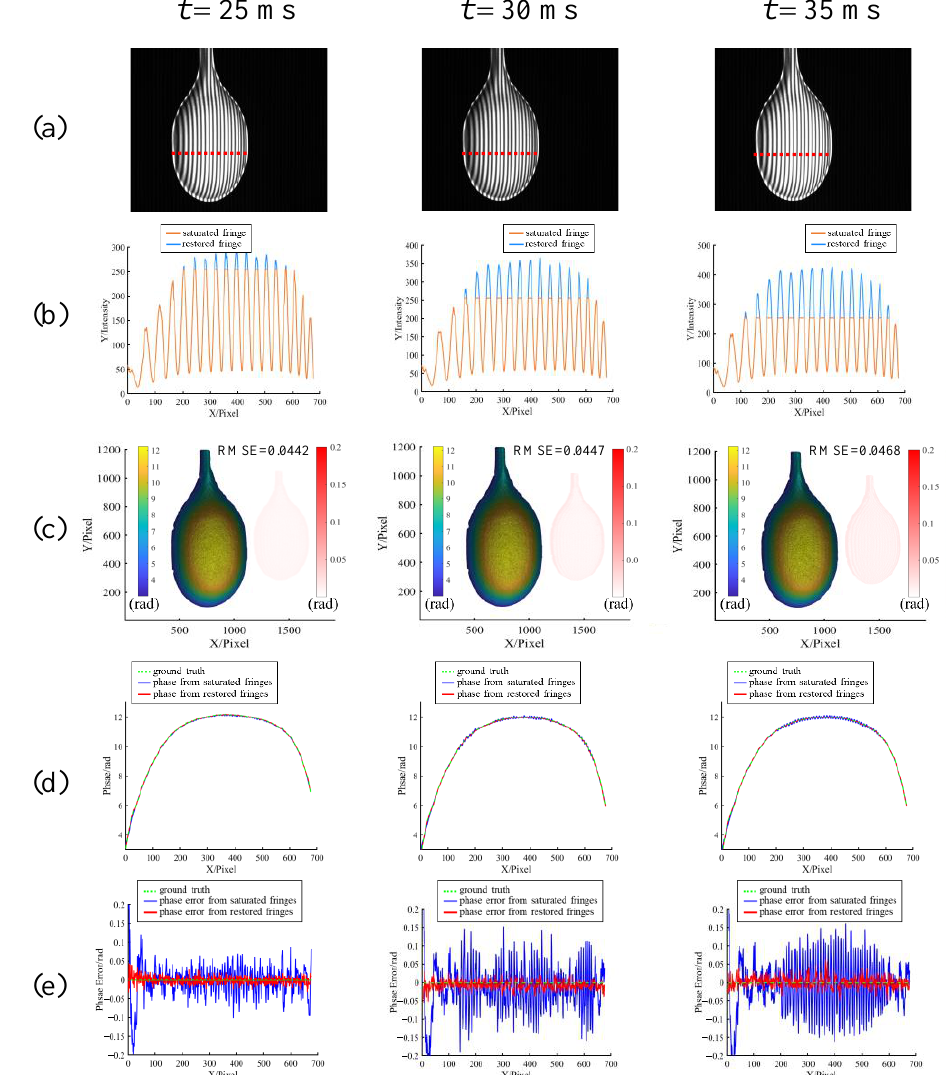
Figure 8. Experimental verification of the proposed method in the cases of saturation generated under different exposure times. The exposure times of the first, second, and third rows are 25 ms , 30 ms , and 35 ms , respectively. ( a ) Saturated fringes. ( b ) Comparison of the section lines of saturated fringe and restored fringe along the red dotted line in ( a ). ( c ) Phases calculated from the restored fringes; the small figures at the right sides represent the error maps. ( d ) Comparison of the section lines of phases calculated from saturated fringes, restored fringes, and ground truth along the red dotted line in ( a ). ( e ) Error comparison of ( d ).